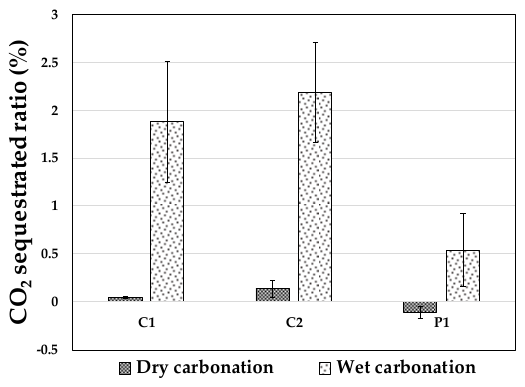
Figure 2. The amount of CO 2 sequestrated in bottom ash samples, quantified using TIC analysis.